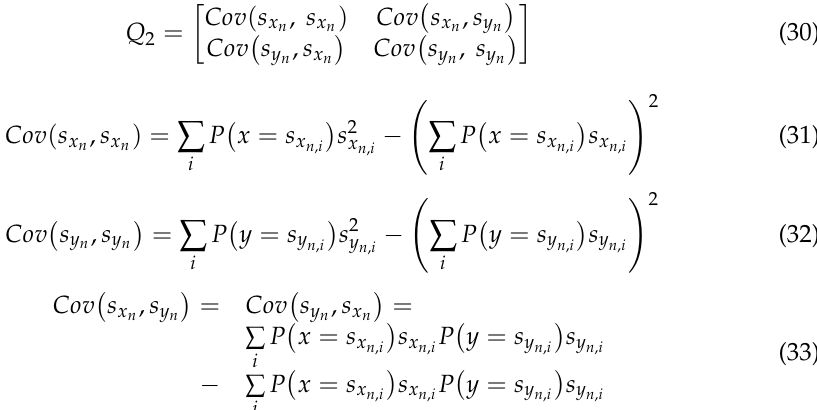
Figure 8. The example of calculating the probability 𝑃(cid:4666)𝑥 = 𝑠 (cid:3051)